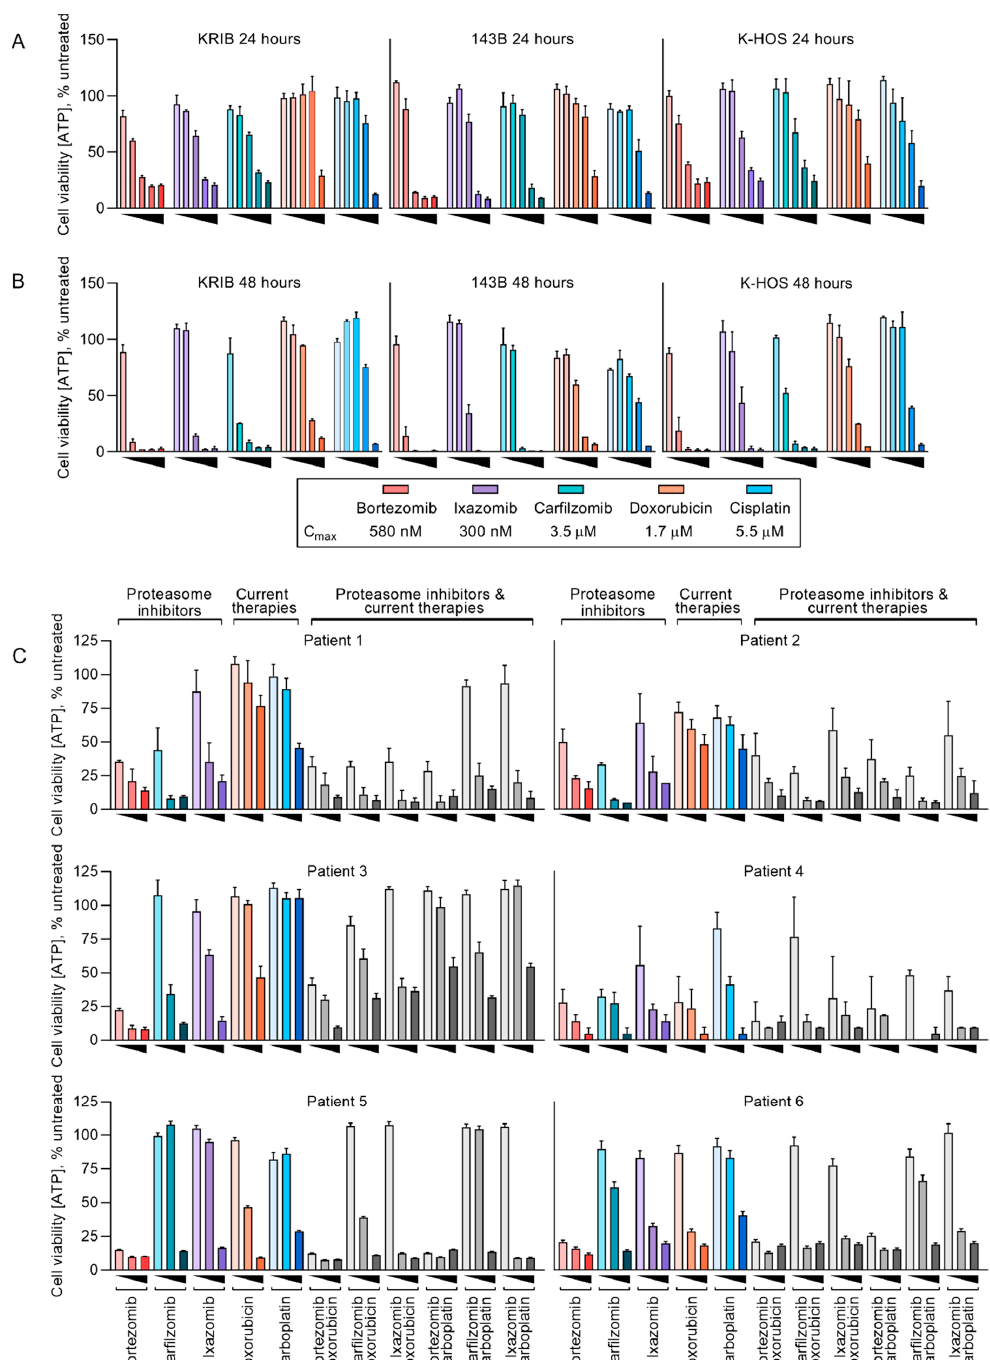
Figure 1. Established and minimally passaged primary osteosarcoma cell lines are more sensitive to proteasome inhibitors than current treatments for osteosarcoma. Established human osteosarcoma cell lines were treated with therapeutic proteasome inhibitors; bortezomib, carfilzomib and ixazomib or current treatments at 0.1%, 1%, 10%, 100% or 10x each drug’s C max for 24 h ( A ) or 48 h ( B ). Cells from six resected canine osteosarcoma tumors were treated with proteasome inhibitors, current treatments for canine osteosarcoma or a combination of each drug class at 1%, 10% or 100% C max for 48 h ( C ). All viabilities reported are relative to untreated samples (n = 3 +/ − SEM).